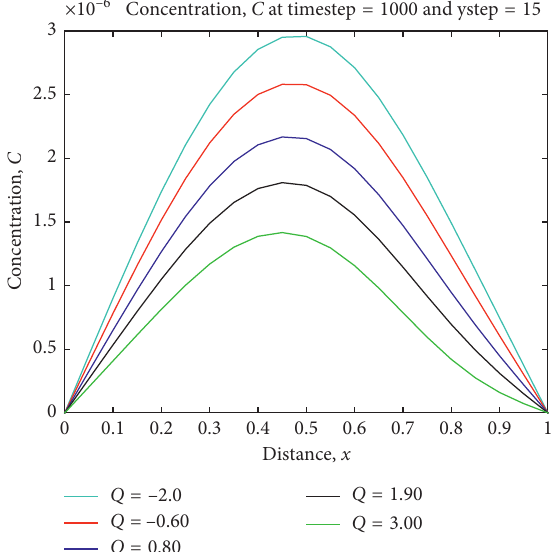
Figure 10: Graph of effects of heat source/sink parameter on concentration profile C .